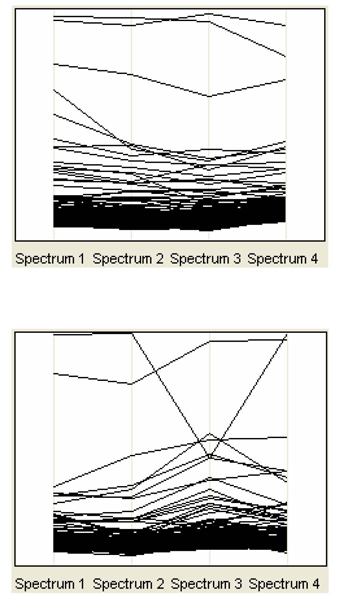
Examples of high and low quality spectra from technical replicates in myeloma-associated lytic bone disease study. The parallel coordinate plots of spectra of four replicates from sera of patients X and Y illustrate the difference between the high quality spectra and low quality spectra. Each peak in the spectra of four replicates were drawn as four points and linked together by a line to show the relative trend. The y-axis is the intensity. (A) Four spectra from replicates of serum of patient X showed very similar profiles and have a high degree of correlation to each other. (B) Spectra 1, 2, and 4 from patient Y have similar profiles and therefore have high correlations to each other. But spectrum 3 has a different profile from the others. Since it is not consistent with the other replicates, it should be discarded prior to data analysis.